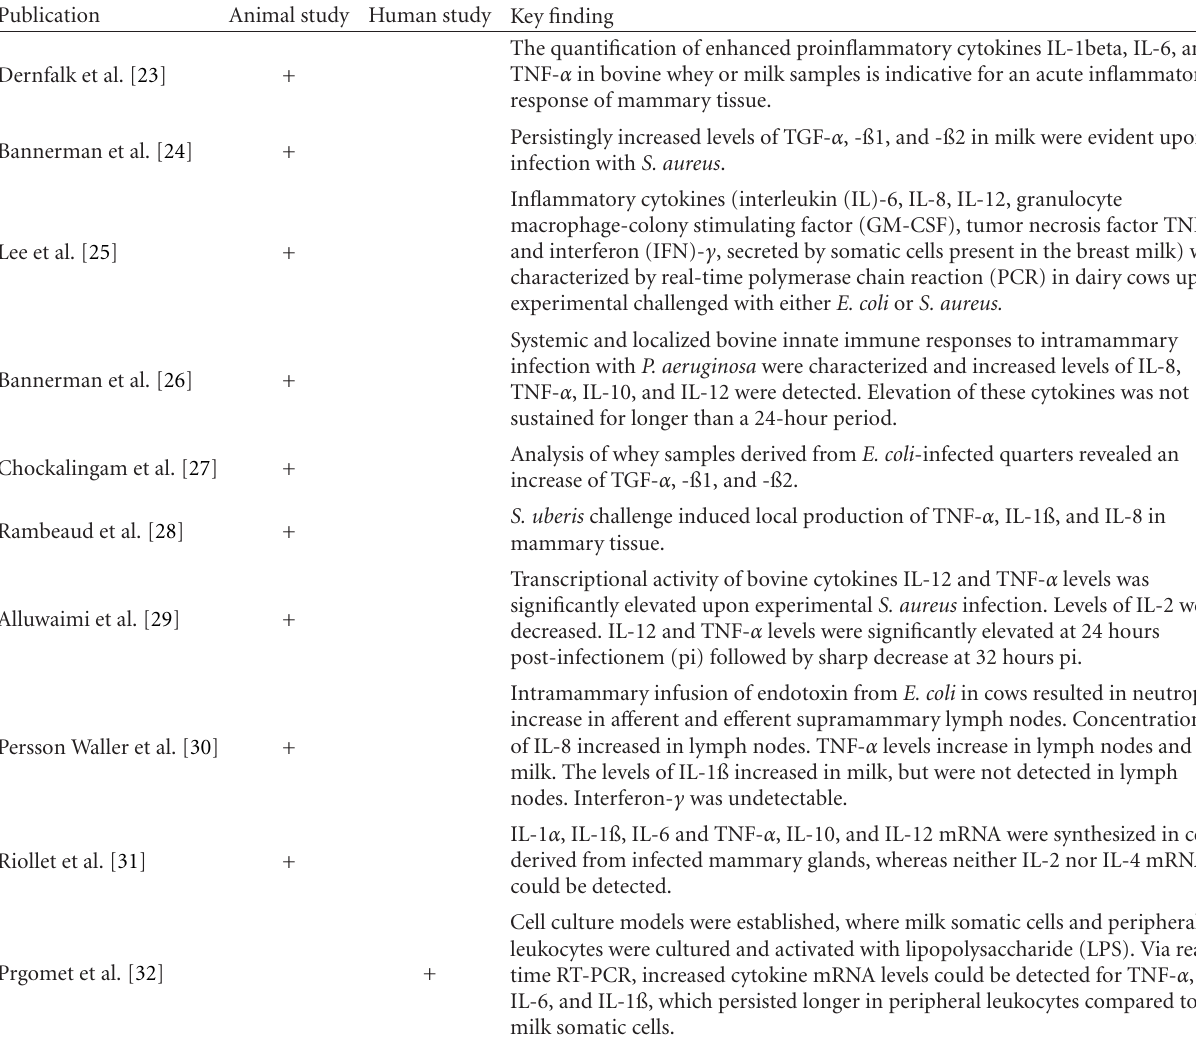
Table 1: Key findings on immune alteration in breast milk, identified upon search for the topic “cytokines detectable in inflammatory processes like a mastitis in breast